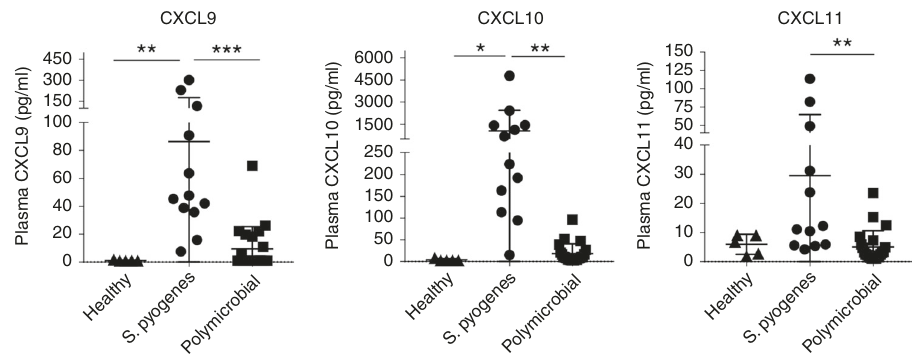
Fig. 6 Plasma levels of interferon-inducible mediators that differ in NSTI patients. The levels of 15 interferon-inducible mediators were measured in the plasma of patients with S. pyogenes ( n = 12) or polymicrobial ( n = 22) NSTIs, or healthy controls ( n = 5) by a multiplex beads array. The levels of those three mediators that differ between patients with polymicrobial and streptococcal NSTIs are shown whereas those of the 12 other mediators are given in Supplementary Figure 12. The mean value (±s.d.) is indicated by a horizontal line. Statistical signi fi cance was evaluated using ordinary one-way ANOVA with * p -value < 0.05; ** p -value < 0.01; ** *p -value < 0.001. Source data are available as a source data fi le